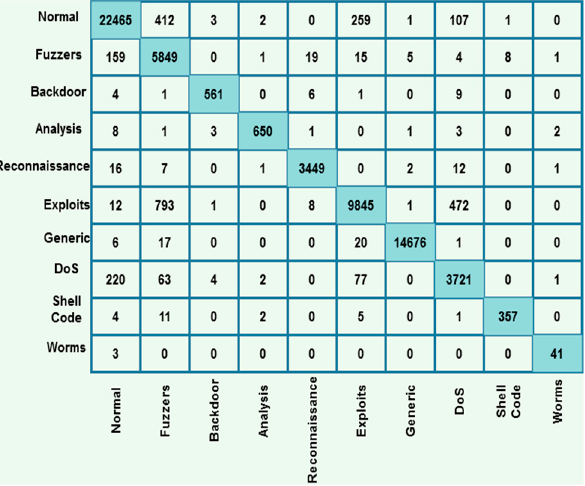
Figure 15. Confusion matrix for dataset 6.